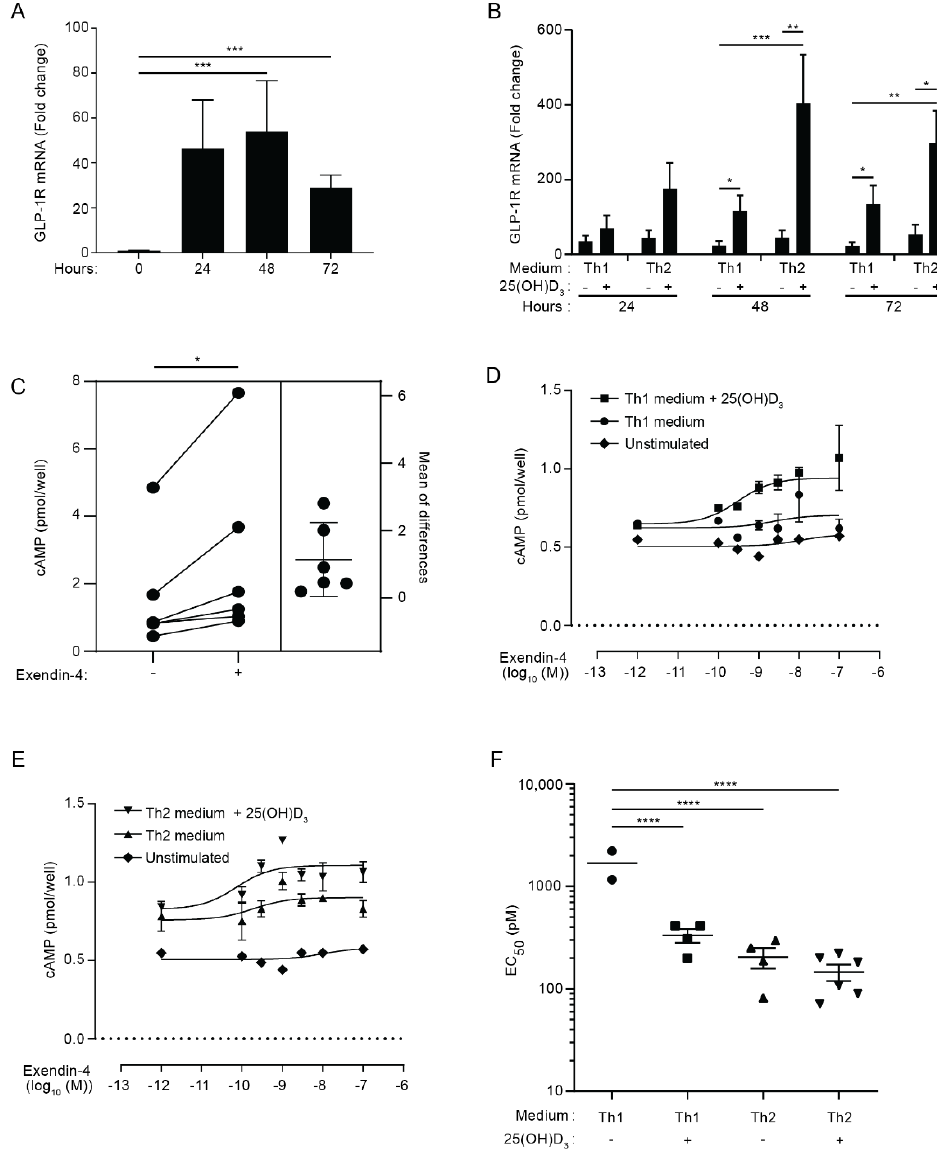
Figure 1. Activated CD4 + T cells express functional GLP-1R. ( A ) Relative GLP-1R expression in naïve CD4 + T cells (0 h) or CD4 + T cells activated for 24, 48, or 72 h. Data are normalized to GLP-1R expression in naïve CD4 + T cells (0 h) (mean + SEM, n = 6, one-way ANOVA with post-hoc test (Tukey’s), *** p ≤ 0.0005). ( B ) Relative GLP-1R expression in CD4 + T cells activated for 24, 48, or 72 h in Th1 or Th2 polarizing medium in the absence or presence of 100 nM 25(OH)D 3 as indicated. Data are normalized to GLP-1R expression in naïve CD4 + T cells (mean + SEM, n ≥ 6, one -way ANOVA with post- hoc test (Tukey’s) for each time group, * p < 0.05, ** p < 0.005, *** p < 0.0005). ( C ) cAMP in CD4 + T cells activated for 60 h in Th2 polarizing medium plus 25(OH)D 3 (100 nM) and subsequently not treated or treated with exendin-4 (10 nM) for 30 min as indicated (estimation plot, n = 6, Stu- dent’s t -test, (paired, two-tailed), * p < 0.05). ( D , E ) cAMP accumulation in CD4 + T cells activated for 60 h in ( D ) Th1 or ( E ) Th2 medium in the absence or presence of 100 nM 25(OH)D 3 and treated with increasing amounts of exendin-4 as indicated. Naïve, unstimulated CD4 + T cells were included as controls. Representative graphs from three independent experiments with six donors run in dupli- cates (mean ± SEM). ( F ) EC 50 values from the nonlinear fits (mean ± SEM, n ≥ 4, one -way ANOVA with post- hoc test (Tukey’s), **** p < 0.00005). The GLP-1R is a class B1 GPCR, and binding of GLP-1 to the GLP-1R causes signaling through a stimulatory G protein that activates adenylyl cyclase (Gαs). The ad enylyl cyclase converts ATP into cAMP, thereby increasing the intracellular concentration of